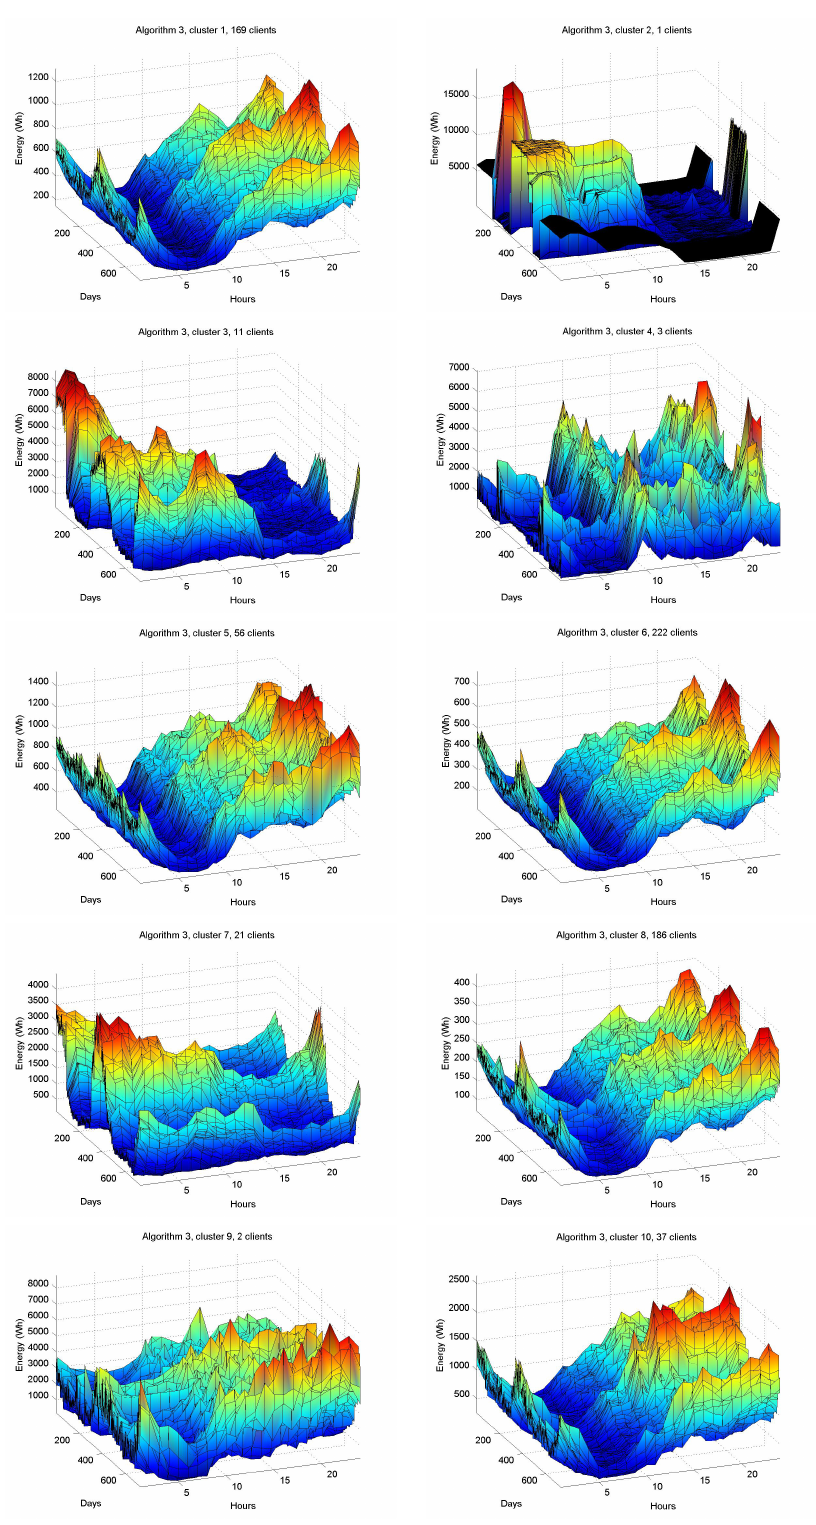
Figure 5. Results of the END-KMH clustering algorithm for segmentation of time